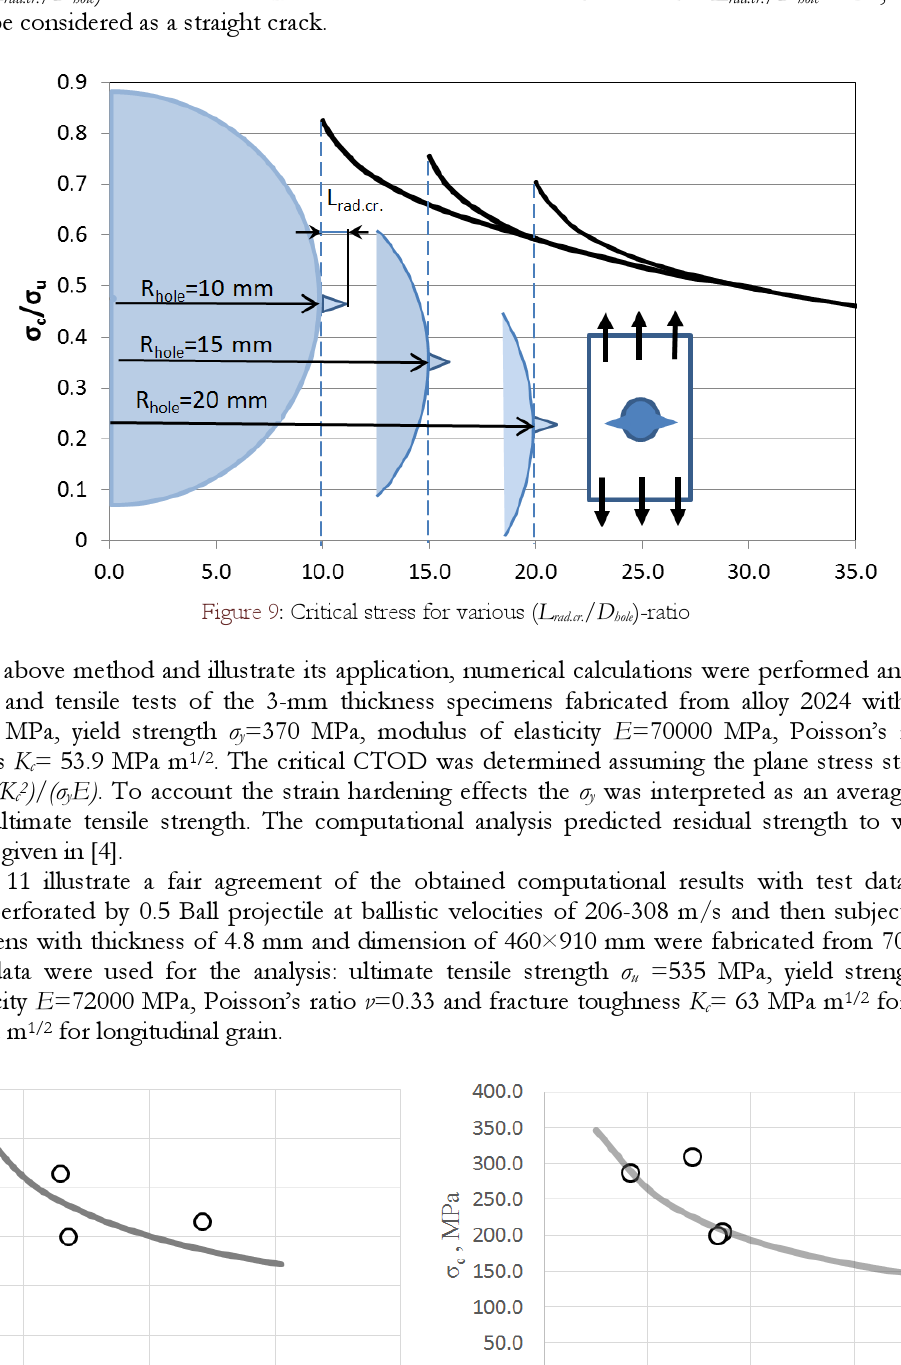
Figure 11: Computational results vs test data [15] (7075-T6 Longitudinal